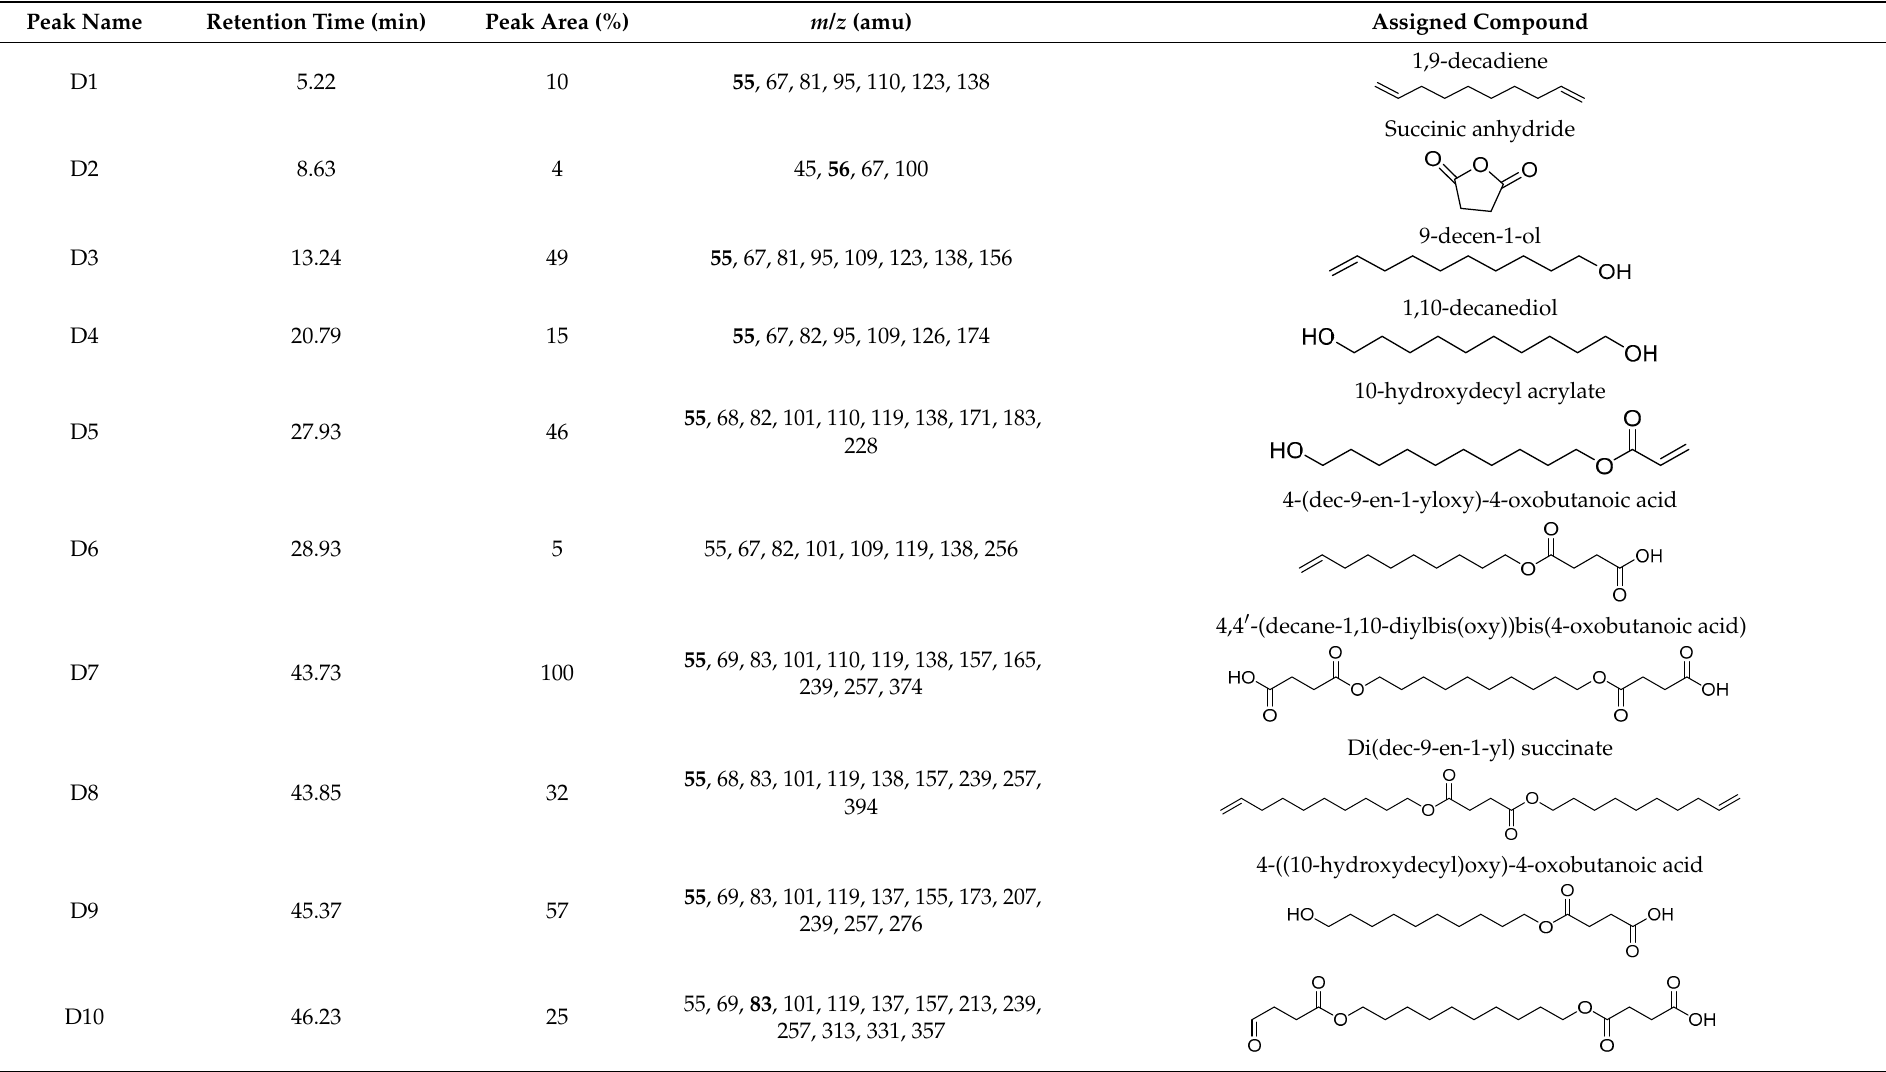
Figure 6. Mass spectra of the major decomposition products of POSu. Table 7. Thermal decomposition products of PDeSu.